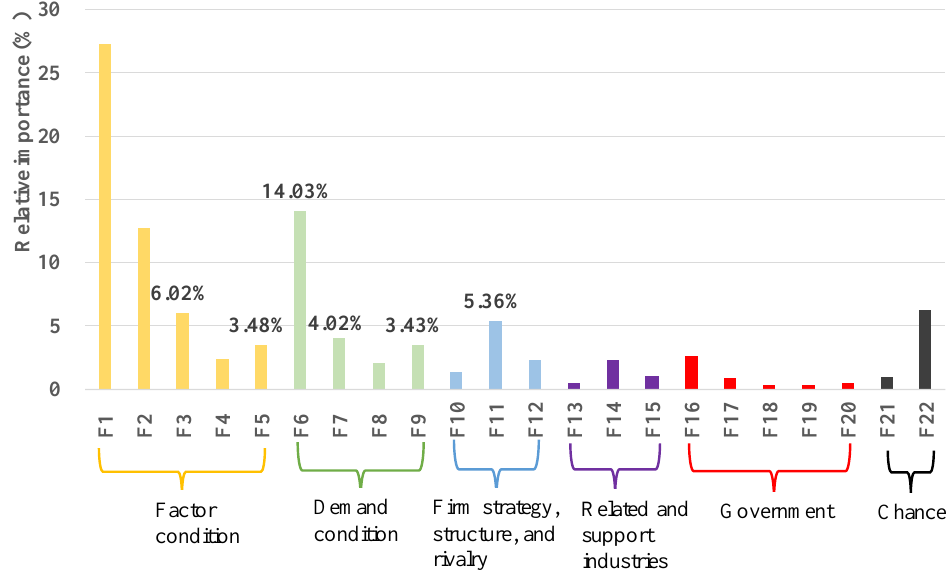
Figure 9. Relative importance of all determinants (see Table 5 for the definitions of F1–F22).